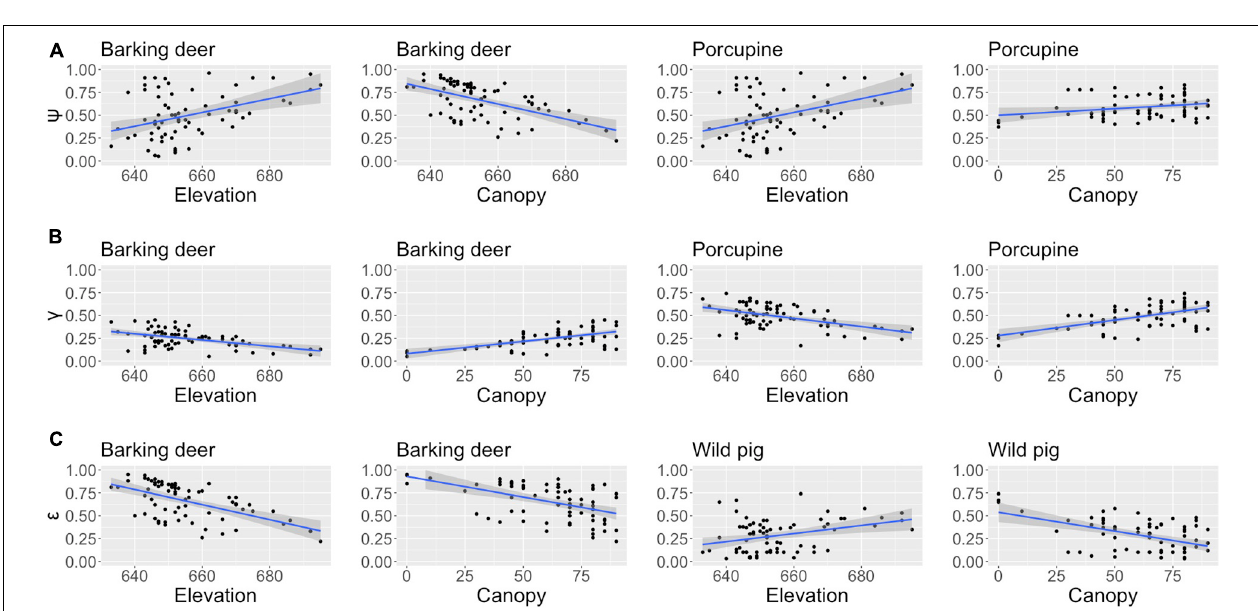
FIGURE 4 | Probability estimates of occupancy, colonization, extinction and detection of all the five species.